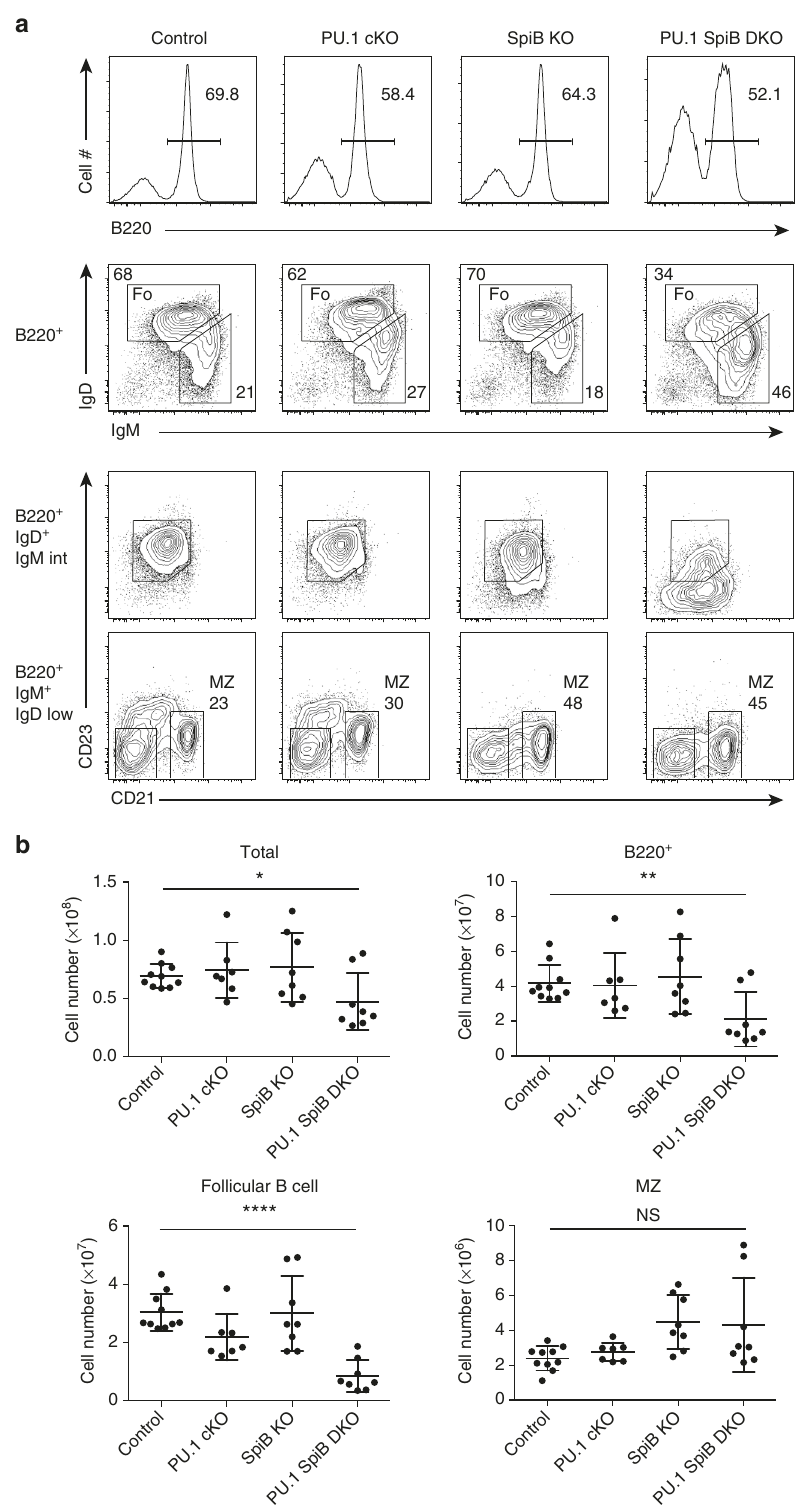
Fig. 1 PU.1 and SpiB regulate follicular B cell numbers. a Flow cytometric analysis of splenocytes from control ( Cd23 T/+ ), PU.1 cKO ( Spi1 fl / fl Cd23 T/+ ), SpiB KO ( Spi1 fl / fl Cd23 +/+ Spib − / − ) and PU.1 SpiB DKO ( Spi1 fl / fl Cd23 T/+ Spib − / − ) mice showing the abbreviated gating strategy for the detection of follicular (Fo) B cells (B220 + IgD + IgM int ) and MZ (B220 + IgM + IgD low CD21 + ) B cells. As the loss of PU.1 and SpiB leads to the downregulation of CD23 expression, follicular B cell numbers were based on the gate for B220 + IgD + IgM int . The full gating strategy is shown in Supplementary Fig. 8A. Data are representative of 7 – 10 mice per genotype. b Absolute cell numbers are graphed as the mean ± s.d. P -values compare the indicated samples (two tailed t -test). Each circle represents the results from an individual mouse. * P < 0.05, ** P < 0.01, **** P <